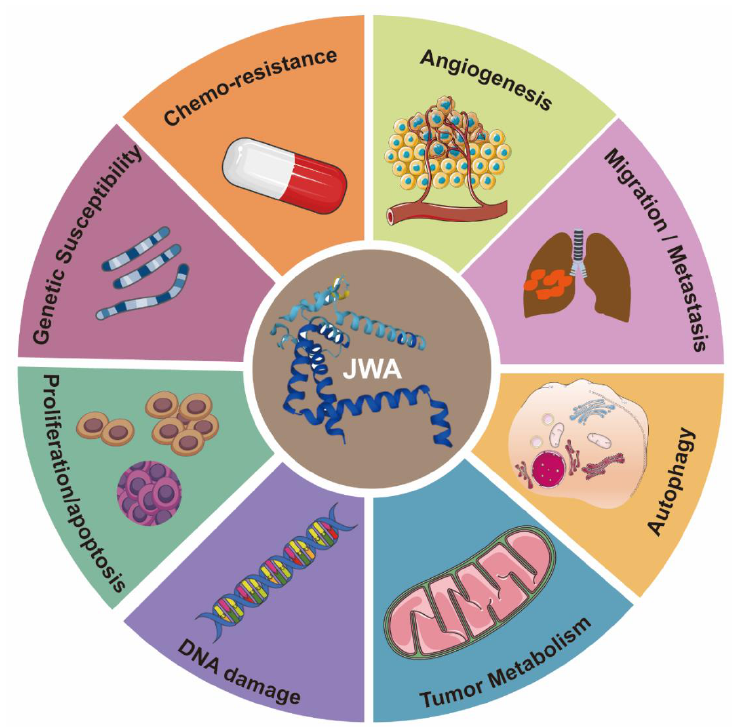
Figure 2. The biological functions of JWA in cancer. JWA inhibits tumor progression by affecting multiple hallmarks of cancer, including angiogenesis, chemo-therapy, genetic susceptibility, prolif- eration, apoptosis, DNA damage, tumor metabolism, autophagy and tumor